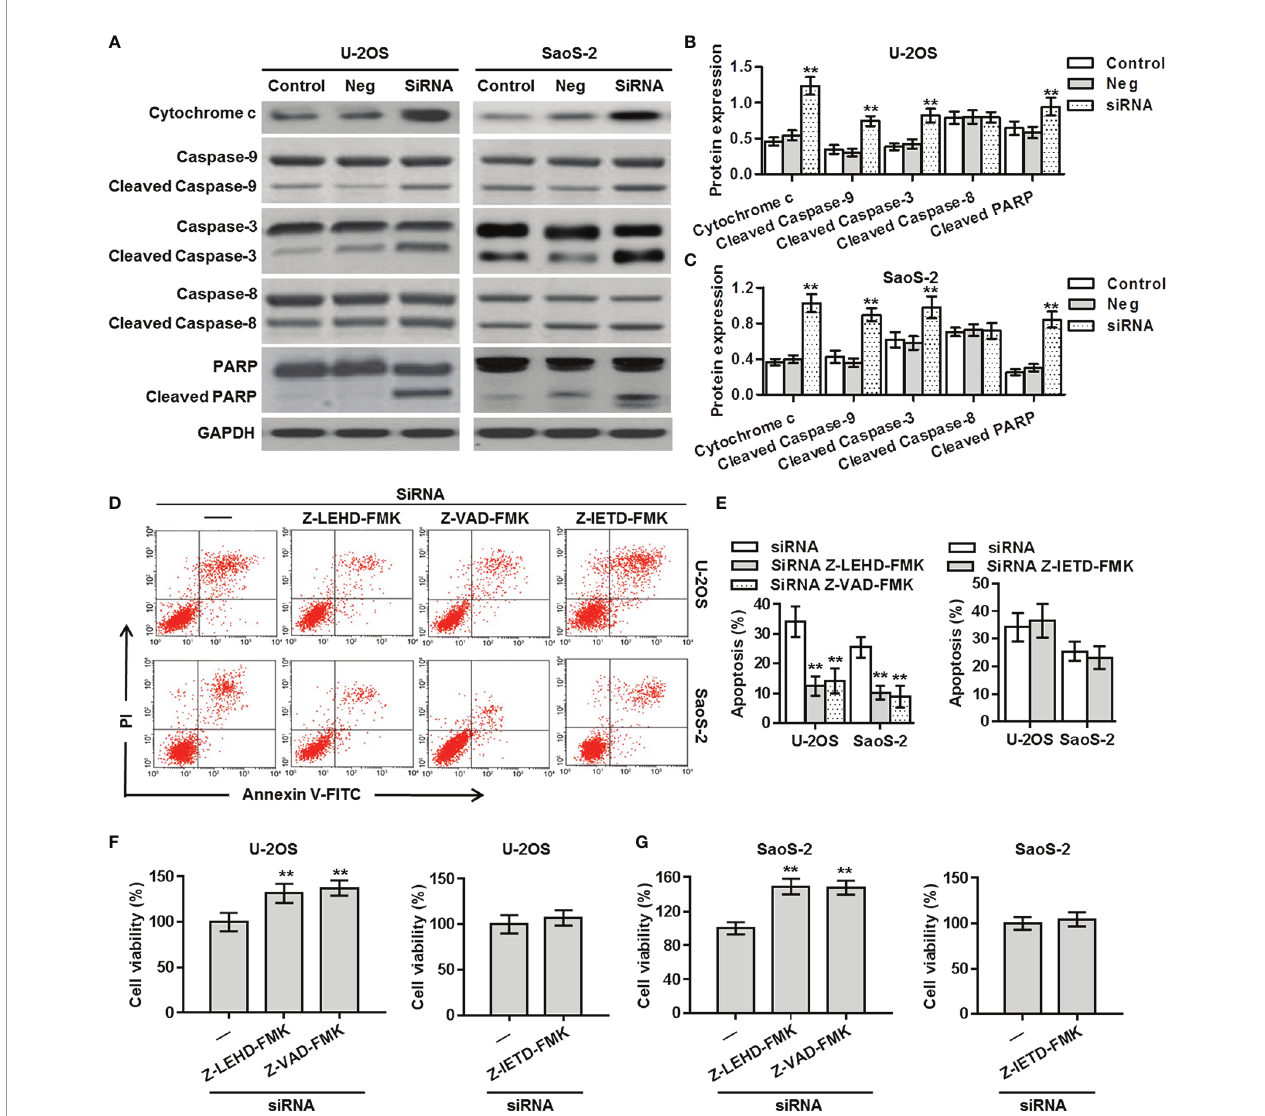
FIGURE 4 | Mitochondria-dependent apoptotic pathway is involved in the effect of ClC-5 knockdown on osteosarcoma cells. (A) The cytosol cytochrome c level, the active forms of caspase-9/8/3, and the cleavage product of PARP were determined in U-2OS and SaoS-2 cells treated with ClC-5 siRNA or negative siRNA (Neg). (B, C) Densitometric analysis of apoptosis-related protein expression was performed in U-2OS (B) and SaoS- 2 (C) cells. **P < 0.01 vs. corresponding control, n = 6. (D, E) U-2OS and SaoS-2 cells were pretreated with caspase-9 inhibitor Z-LEHD-FMK (10 m M), caspase-3 inhibitor Z-IETD-FMK (20 m M), or caspase-8 inhibitor Z-VAD-FMK (25 m M) for 30 min before ClC-5 siRNA transfection. Cell apoptosis was determined by Annexin V/PI staining (D) . Quantitative analysis of the percentage of apoptotic cells (E) . **P < 0.01 vs. siRNA, n = 4. (F, G) Cell viability of U-2OS (F) and SaoS-2 (G) was determined. **P < 0.01 vs. siRNA, n =